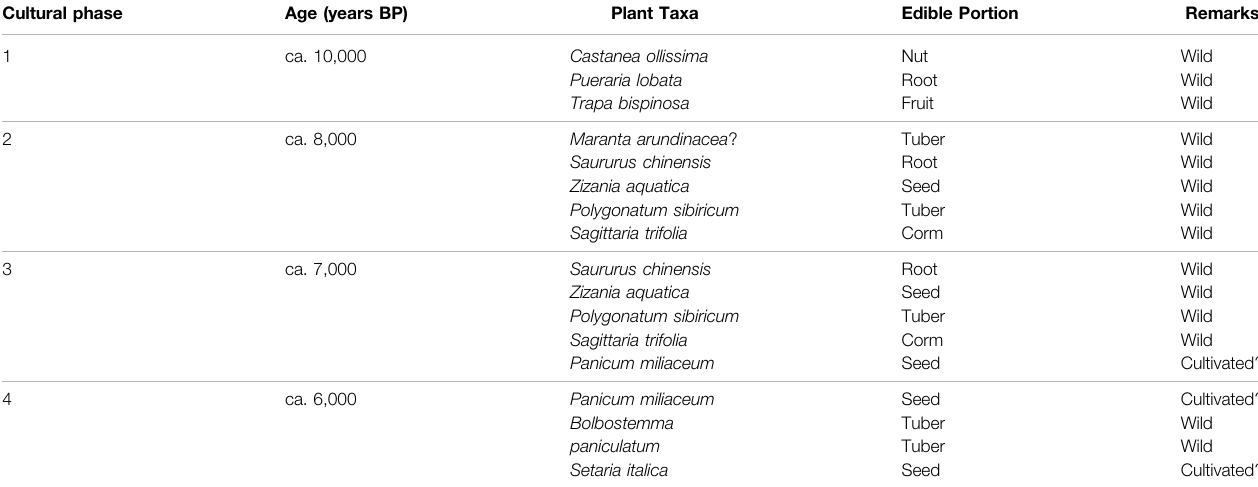
TABLE 4 | Starch taxa associated with different cultural stages at the Dingsishan Site. Cultural